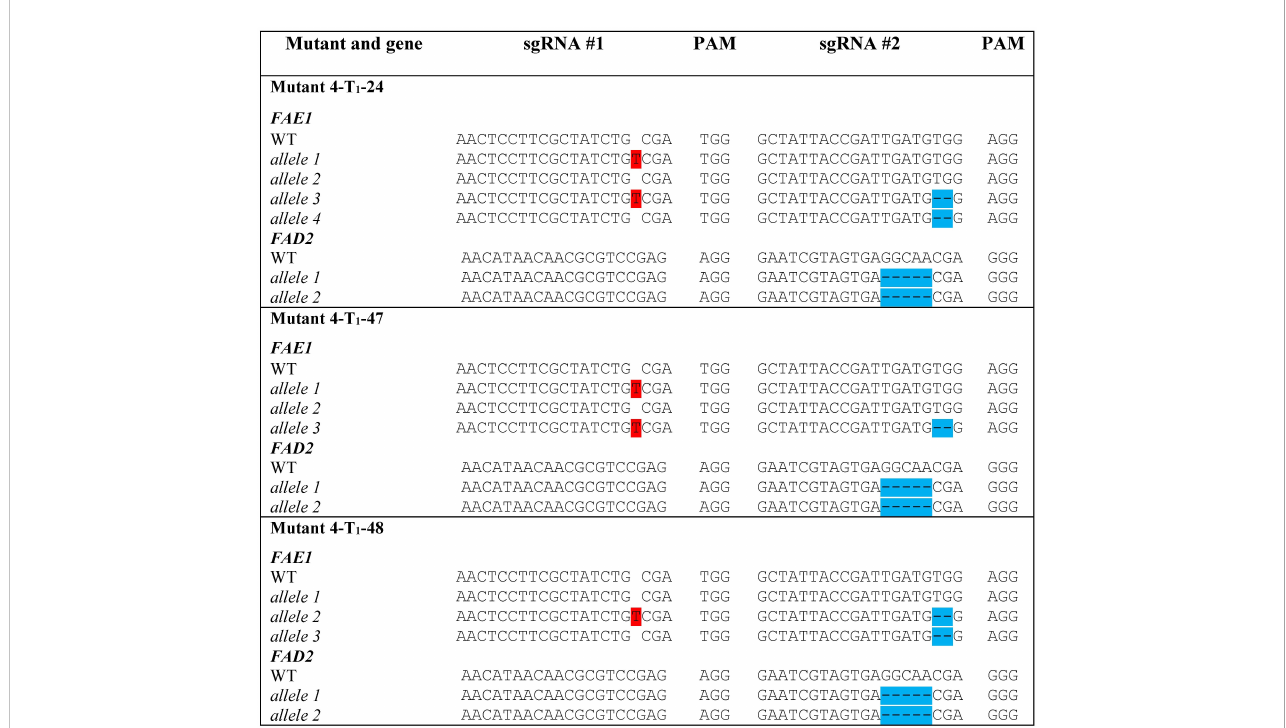
FIGURE 5 Types of mutations detected in FAE1 and FAD2 in selected seeds from the T 1 generation of Mutant 4. Insertions are highlighted in red. Deletions are highlighted in